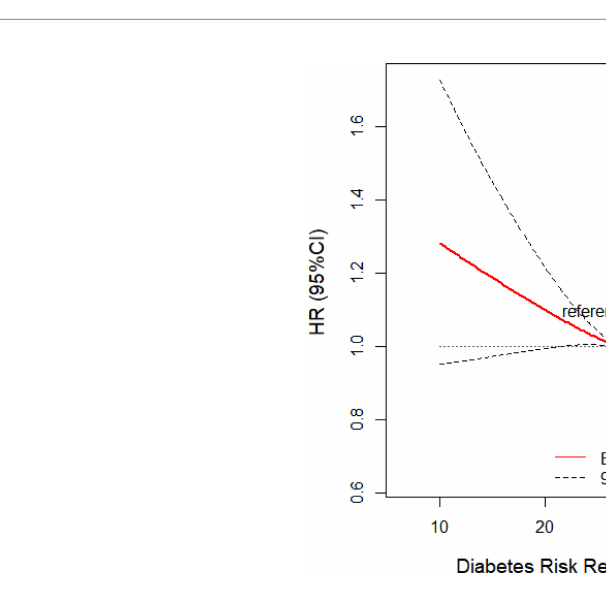
*Adjusted for age (continuous), sex (male or female), BMI (continuous), total energy intake (continuous), family history of lung cancer (yes, no, or possible), marital status (married ornot married), race/ethnicity (white or non-white), smoking status (never, former smoker, current smoker), pack-years of cigarettes (continuous), alcohol intake (never, former, current, or unknown), history of diabetes (yes vs.